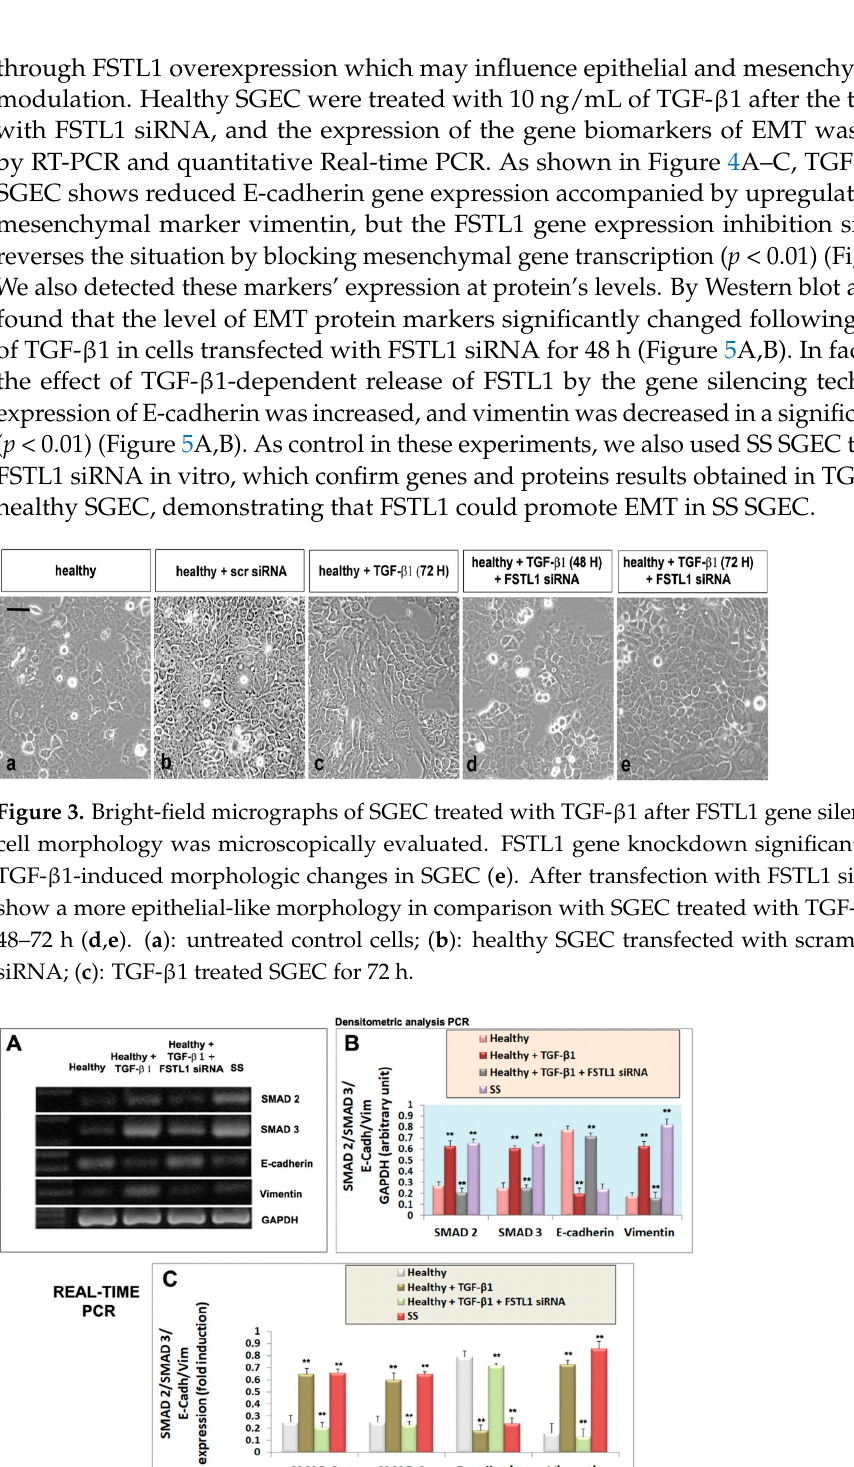
Figure 5. ( A ): representative Western blot analysis of E-cadherin, vimentin, total SMAD2/3 and P- SMAD2/3 proteins expression in healthy untreated control SGEC (lane 1), healthy SGEC treated with TGF- β 1 for 48 h (lane 2), cells transfected with FSTL1 siRNA and subsequently treated with TGF- β 1 for 48 h (lane 3). SS SGEC protein lysate was used as a positive control. For quantitative analysis banding densities were compared with test marker β -actin ( B ). Data are expressed as a significant change relative to the untreated control cells. Each bar represents the mean ± SE. **, p < 0.01. Each experiment was repeated three times.